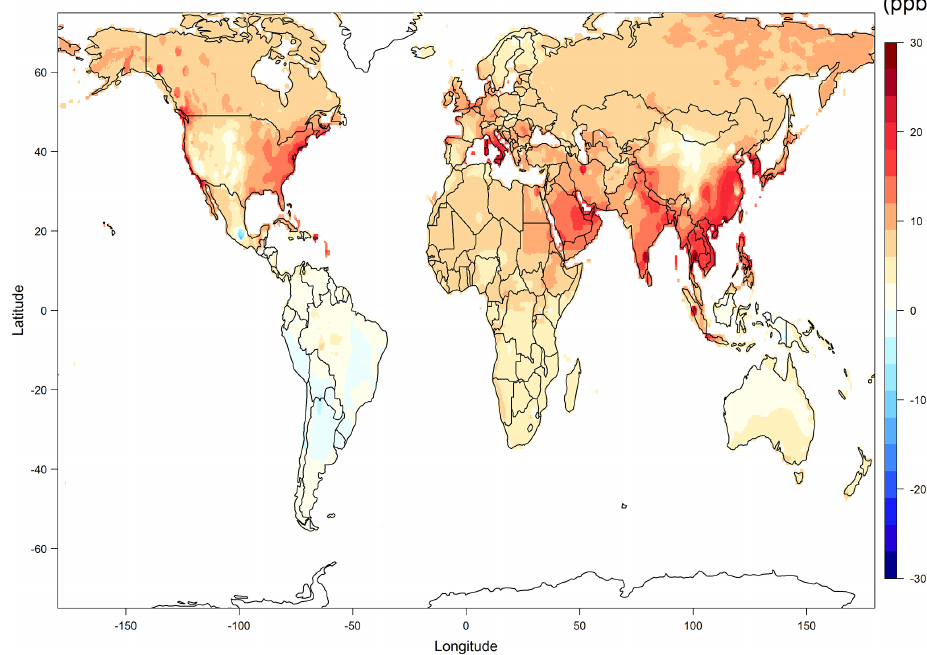
Figure 8. Map showing result for multi-model mean minus the fused surface